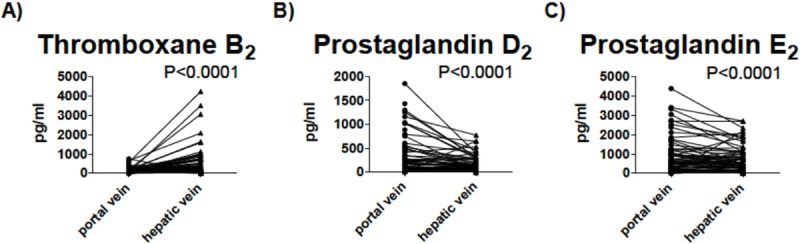
Levels of Thromboxane B2 (A), Prostaglandin D2 (B) and Prostaglandin E2 (C) in portal compared to hepatic vein. Wilcoxon matched-pairs signed-ranks test was used to compare differences. P-values <0.05 were considered statistically significant. N = 89.